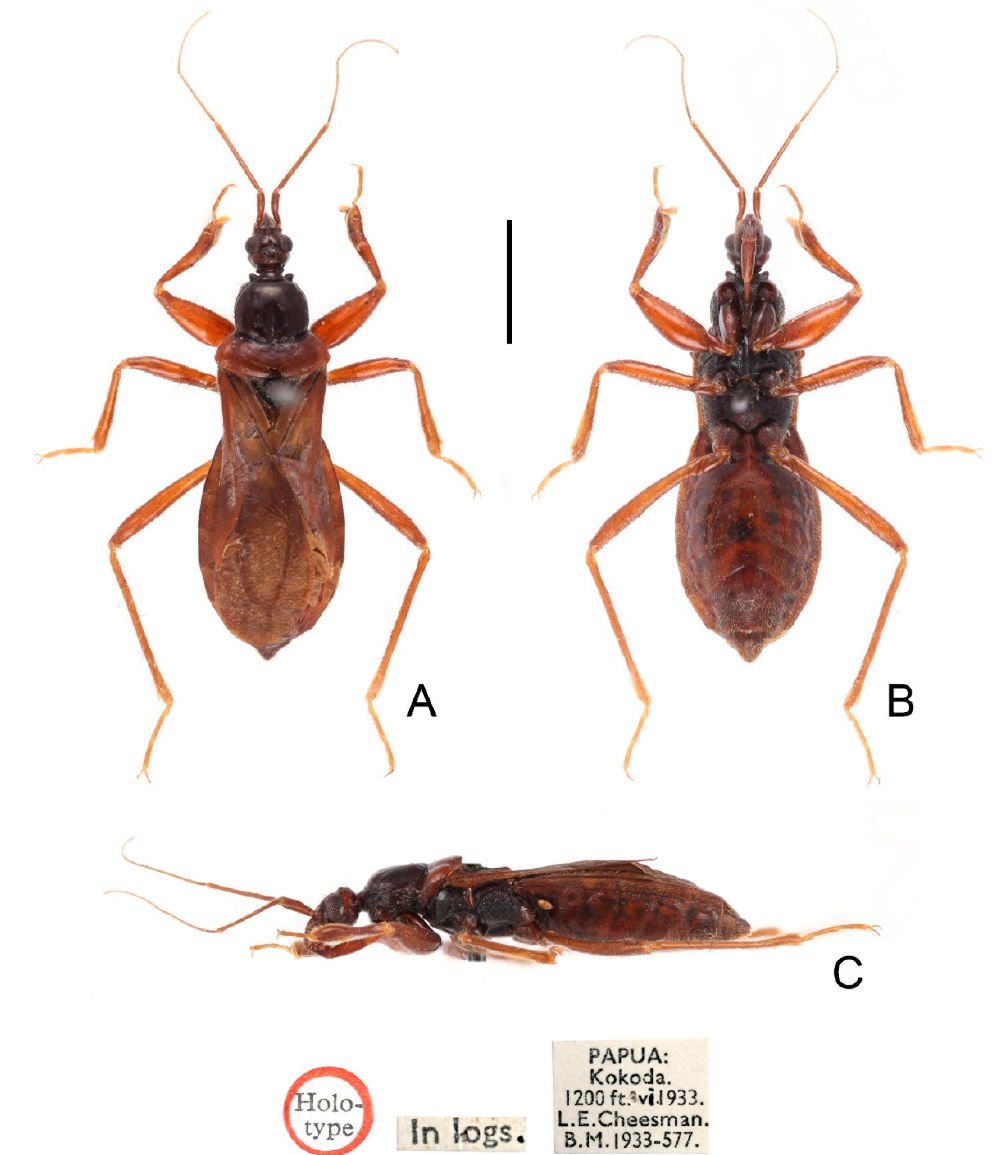
Figure 6. Sigicoris dominiqueae sp. nov. , holotype female, habitus. ( A ) Dorsal view. ( B ) Ventral view. ( C ) Lateral view. Scale bar = 3.00 mm.